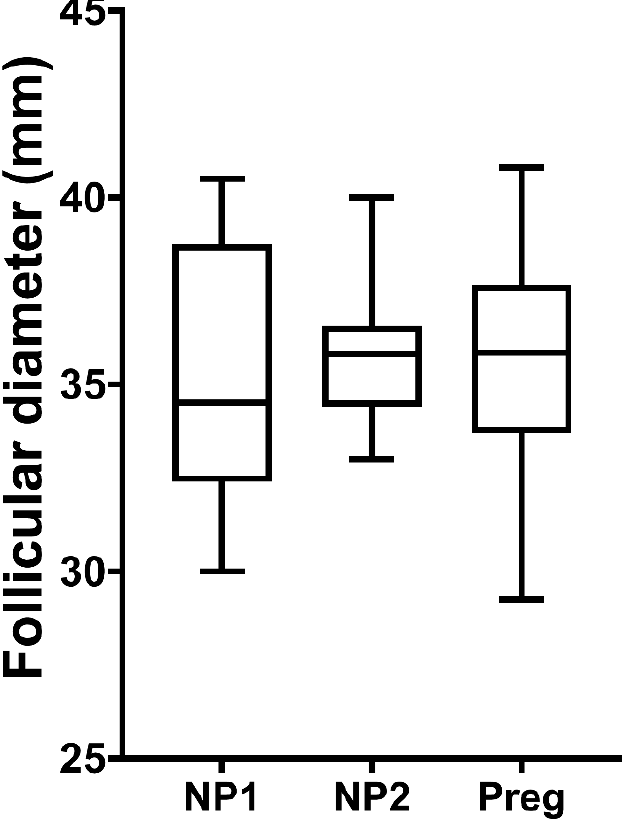
Figure 2. Box plots of the preovulatory follicle diameter in jennies ( n = 8) in two non-pregnant cycles (NP1 and NP2) and one cycle when the jennies became pregnant after breeding (Preg). The pre-ovulatory diameters were recorded 24 h before the ovulation was